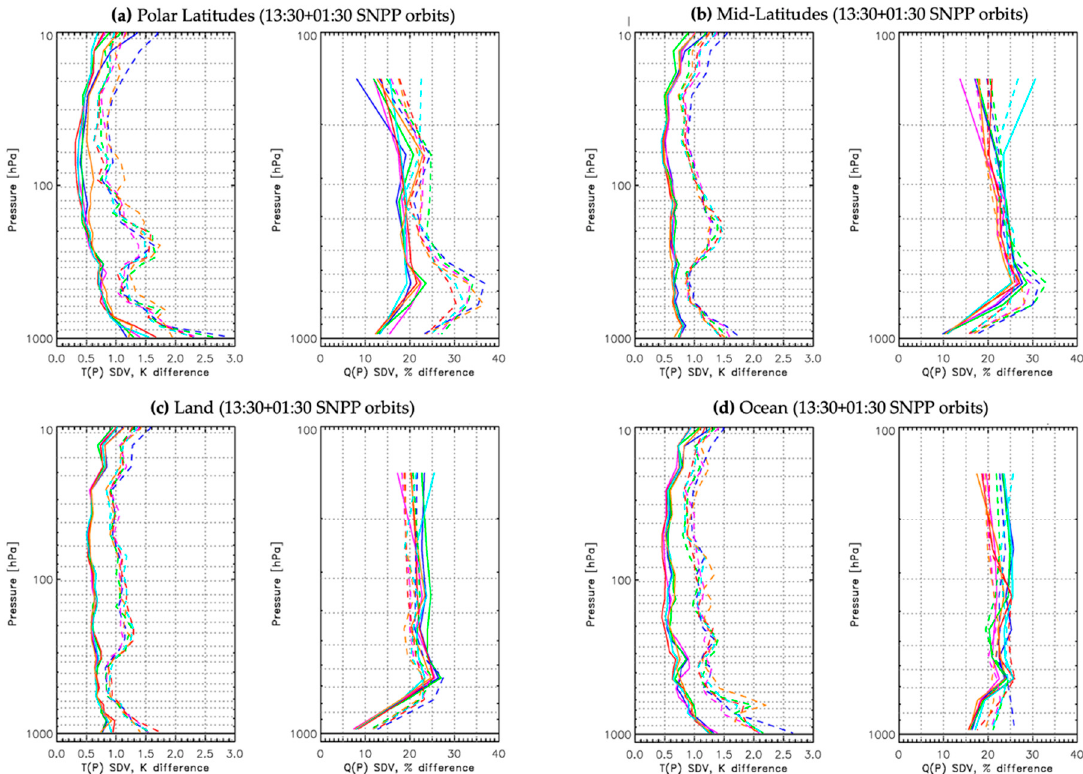
Figure 10. NUCAPS (dashed lines) versus CLIMCAPS (solid lines) over di ff erent geographic regions, ( a ) Polar latitudes ( > 60 ◦ north and south), ( b ) Mid-latitudes (between 60 ◦ and 30 ◦ north and south), ( c ) over land and ( d ) over ocean. Scene-dependent uncertainty as the standard deviation (SDV) with respect to ECMWF for retrieved temperature T(p) in units Kelvin and water vapor Q(p) as percent from six global days of SNPP / CrIS measurements.